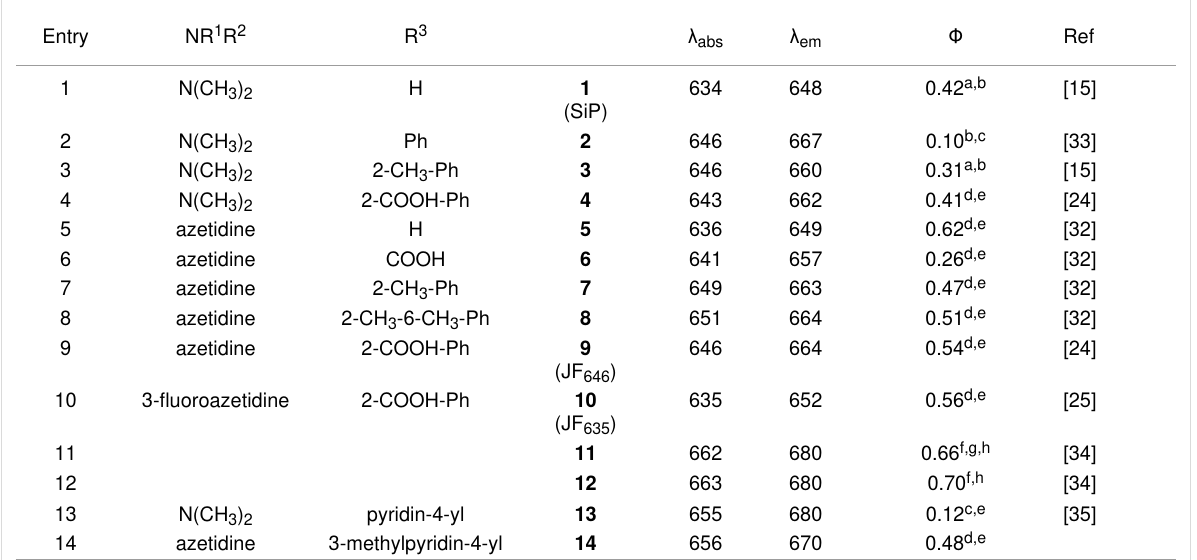
Table 1: Comparison of optical properties of different silicon